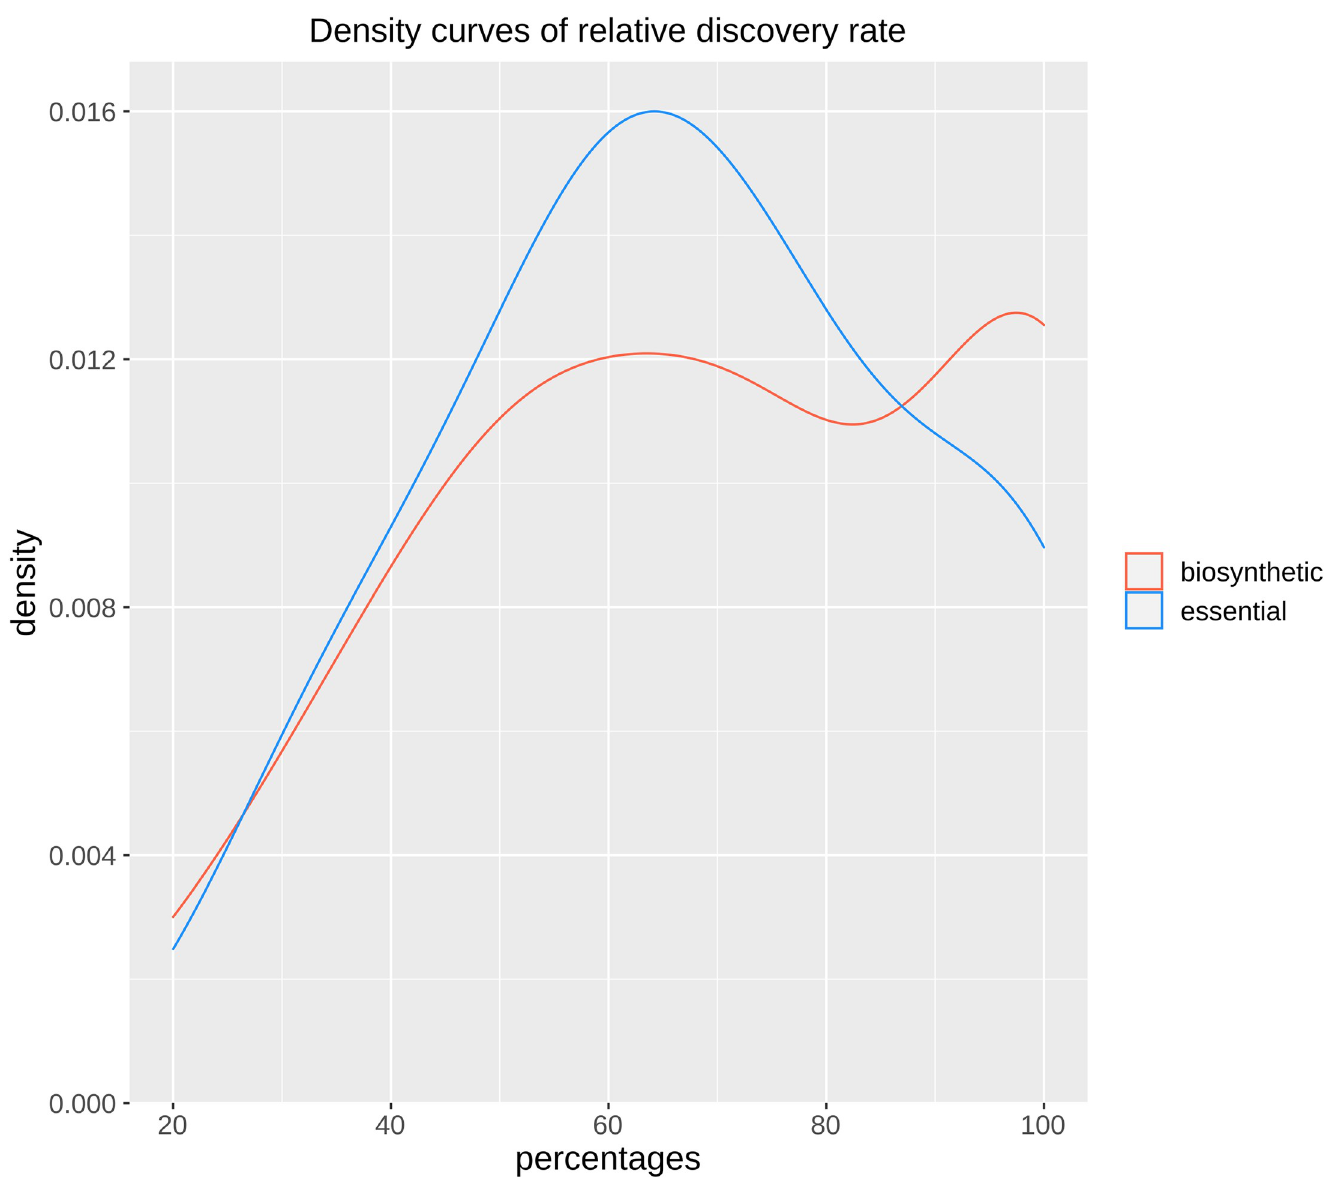
Fig 5. Kernel density plots of the relative discovery rate of essential or biosynthetic genes in 30 tested fungal BGCs.